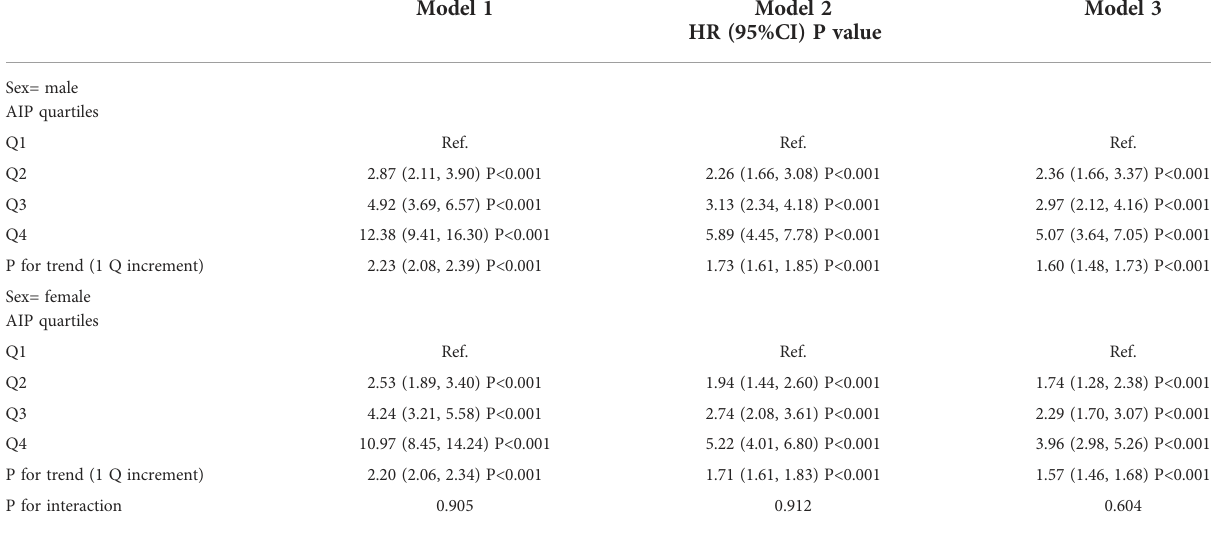
TABLE 3 Association between AIP and new-onset NAFLD according to sex.